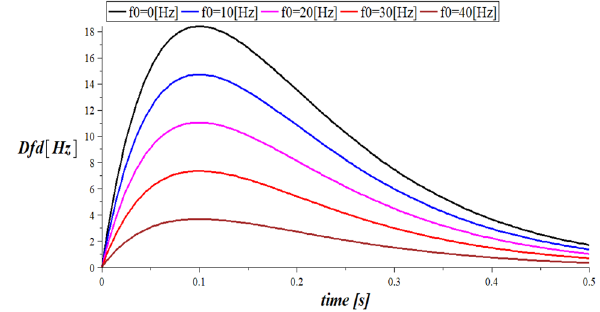
Fig. 10 Frequency of the voltage (dotted line, f 0 = 0 (Hz) ) and dynamic frequency f c 3 ( t ) of current for exponential increase of voltage frequency from f 0 = 0,10,20,30,40 (Hz) to f k = 50 (Hz) ; T = 0.075 s